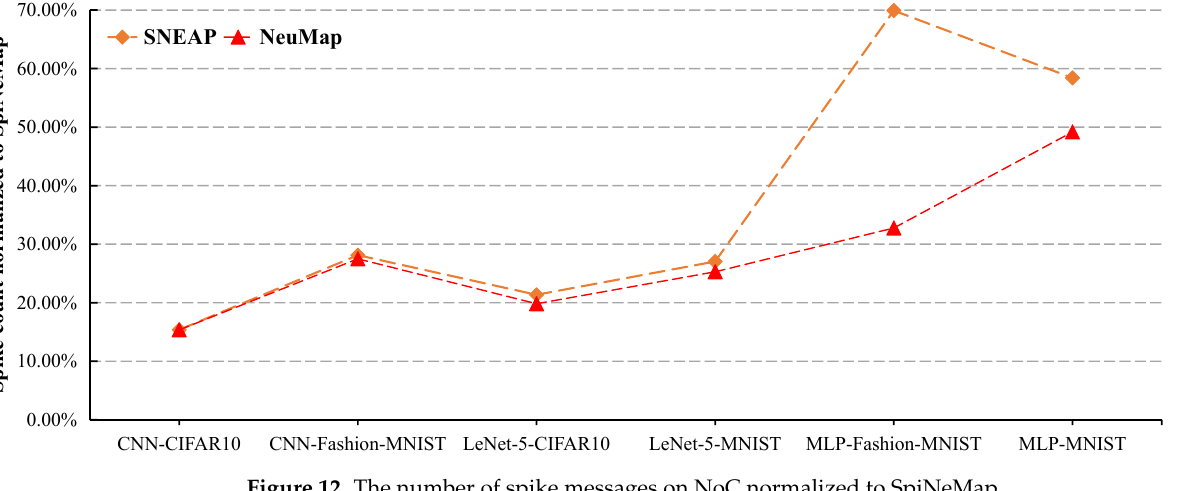
Figure 12. The number of spike messages on NoC normalized to